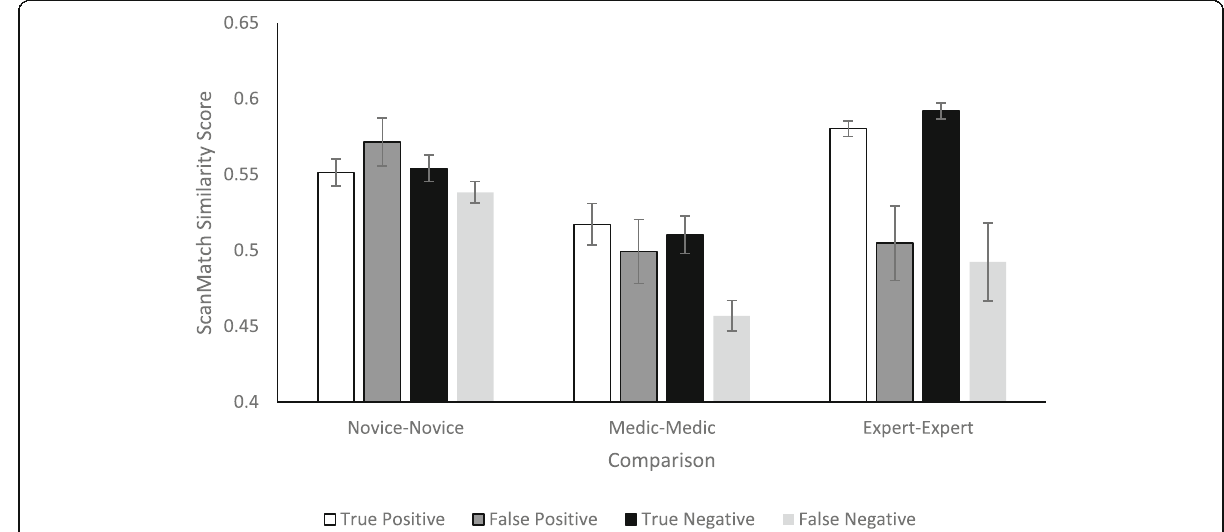
Fig. 7 Interaction between within-group comparison and stimulus-response classification on ScanMatch similarity score. Error bars represent standard error